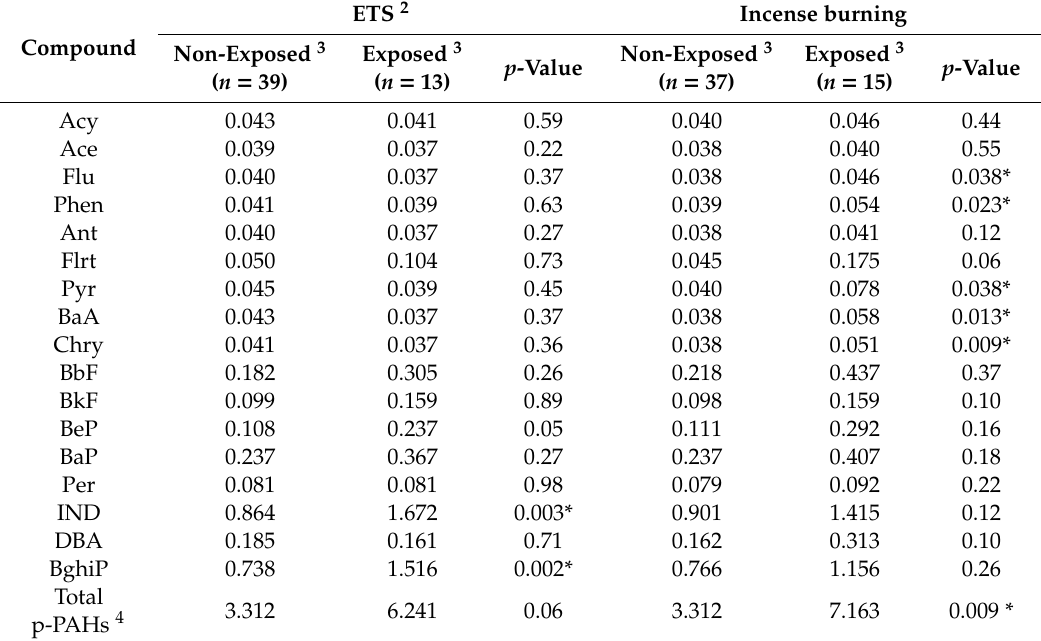
Table 3. Comparison of p-PAH concentrations for children exposed to potential pollution sources 1